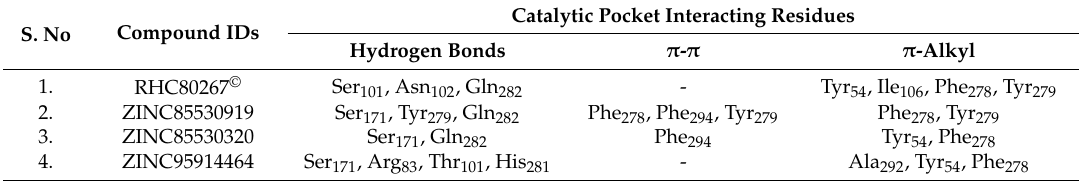
Table 3. List of selected compounds with their interacting residues of Mrlip1.